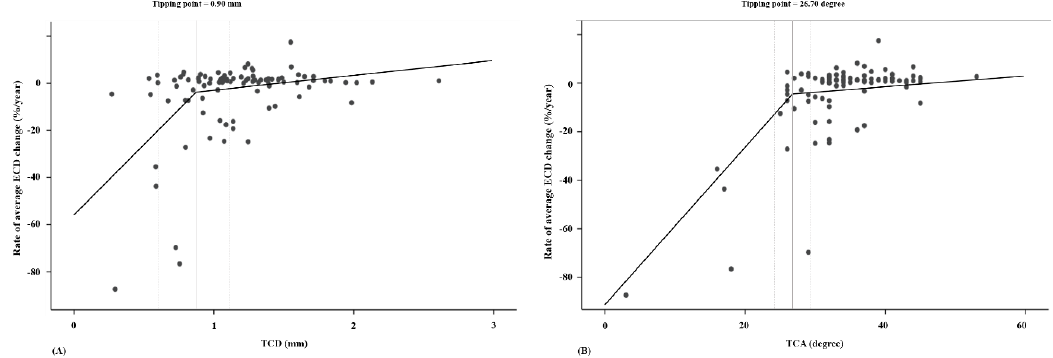
Figure 2. Scatter plots of the relationships between tube parameters and the rate of change in average endothelial cell density (ECD) in all patients: ( A ) tube-cornea distance (TCD), ( B ) tube-cornea angle (TCA). The tipping points of the TCD and TCA are 0.90 mm (95% confidence interval (CI): 0.68–1.11) and 26.70° (23.75–29.64°), respectively. The slopes for the rate of average ECD change as a TCD below and above the tipping point are 56.36 and 4.45, respectively ( p = 0.003). The tipping point of the TCA location is not statistically significant ( p = 0.366), and there is a significant difference between the rates below and above the slopes (3.75 and 0.57, respectively; p < 0.001).